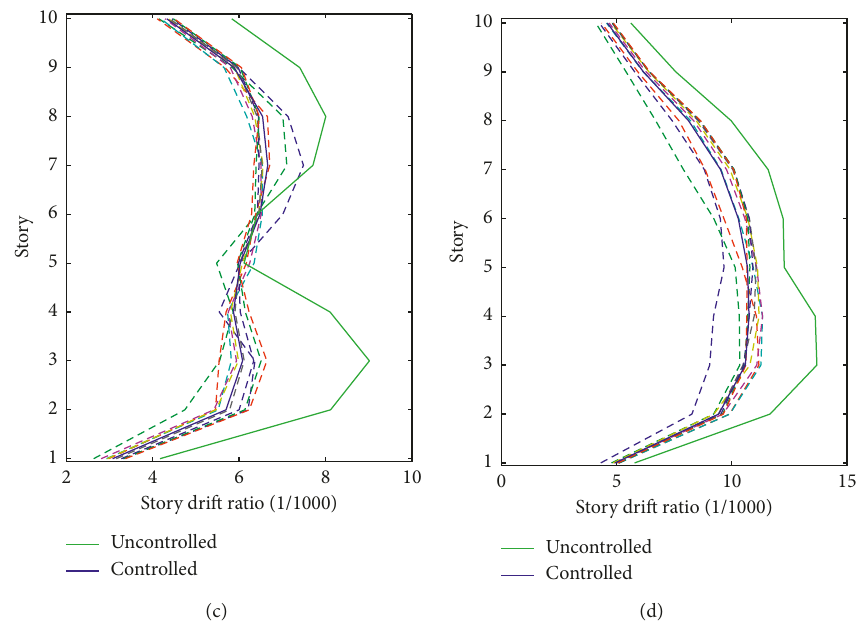
Figure 13: Control effect of structural interstory drift under 0.3g peak value conditions (dashed lines indicate different schemes, blue solid lines indicate the mean value of the different schemes, and green solid lines indicate the uncontrolled structures): (a) El Centro; (b) Hachinohe; (c) Kobe; (d)